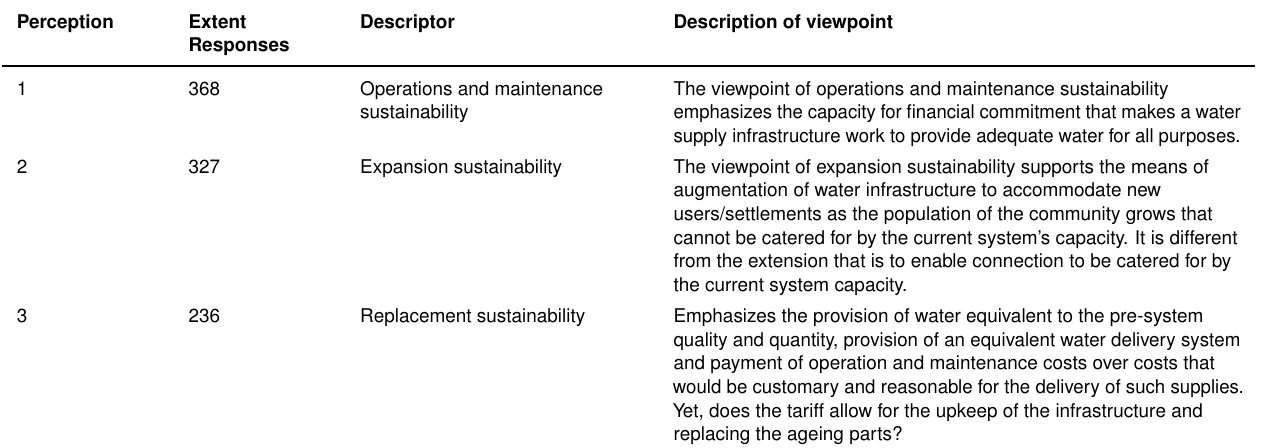
Table 1. Description of the